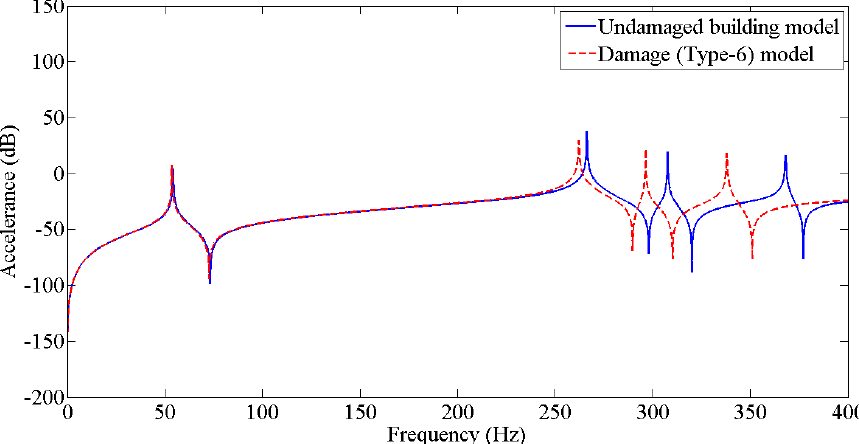
Figure 11. Prediction of structural dynamic behavior of building model under undamaged and damaged (Type − 6) conditions through FRFs. Table 4. Elevation (mm) of all damage conditions.